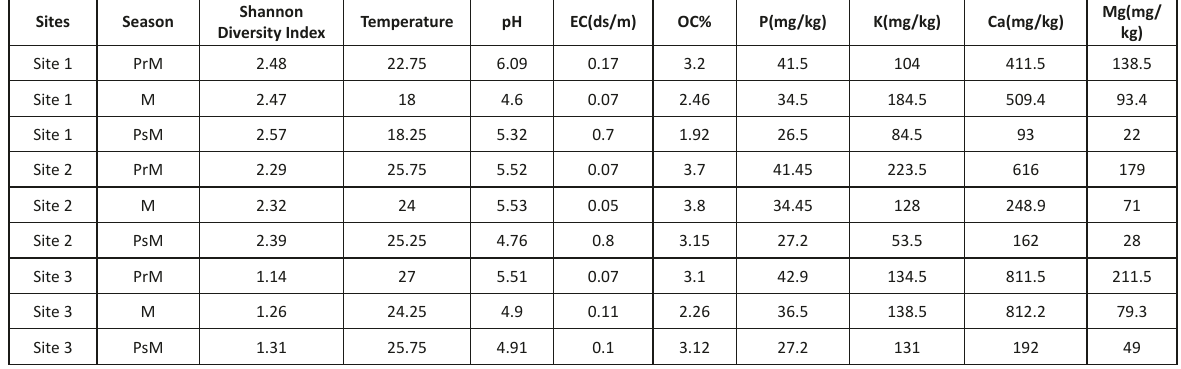
Table 4. Mean Index and Soil Physico-Chemical properties of three sites across 3